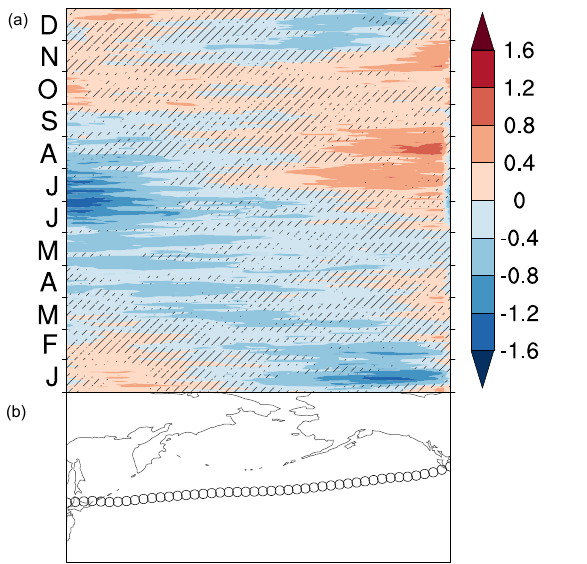
Figure 7. (a) Multi-model mean shift of the North Pacific eddy- driven jet (shading; in degrees latitude) in the 2.0 ◦ C experiment compared to the PD experiment as a function of longitude and time. Hatching masks out regions where there is no model consensus (fewer than four out of five models agree) on the sign of the re- sponse. (b) Climatological position of the jet in the PD experiment. Jet latitude is calculated following Simpson et al.